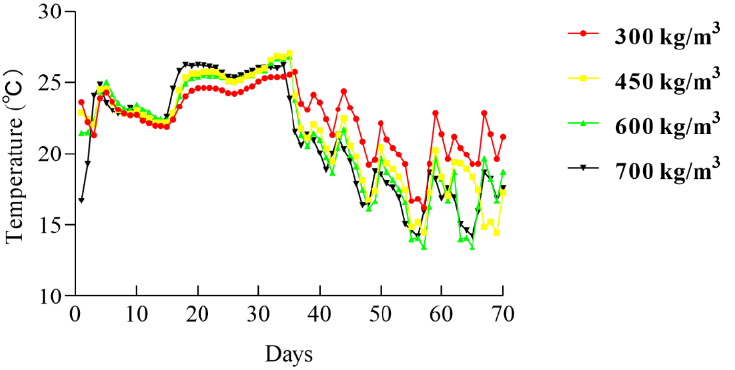
Figure 1. Fermentation temperature curve of whole-plant corn silage under different compaction density.